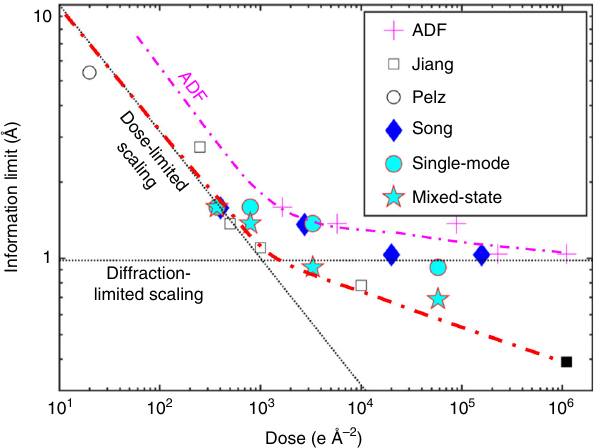
Fig. 3 Summary of dose dependence of information limit from ADF and electron ptychography. The opened markers are electron ptychographic results using simulated data from references Jiang et al. and Pelz et al. The fi lled markers are experimental results by electron ptychography from Song et al. and this manuscript. The single-mode and mixed-state results are from Fig. 4 in the main text. Resolution by dose-limit, inversely proportional to square root of dose (linear in log-log plot), and by aperture limit are guided by dashed lines. Information limit for ADF (plus makers) is measured from low-angle ADF images of monolayer WS 2 synthesized from in-focused